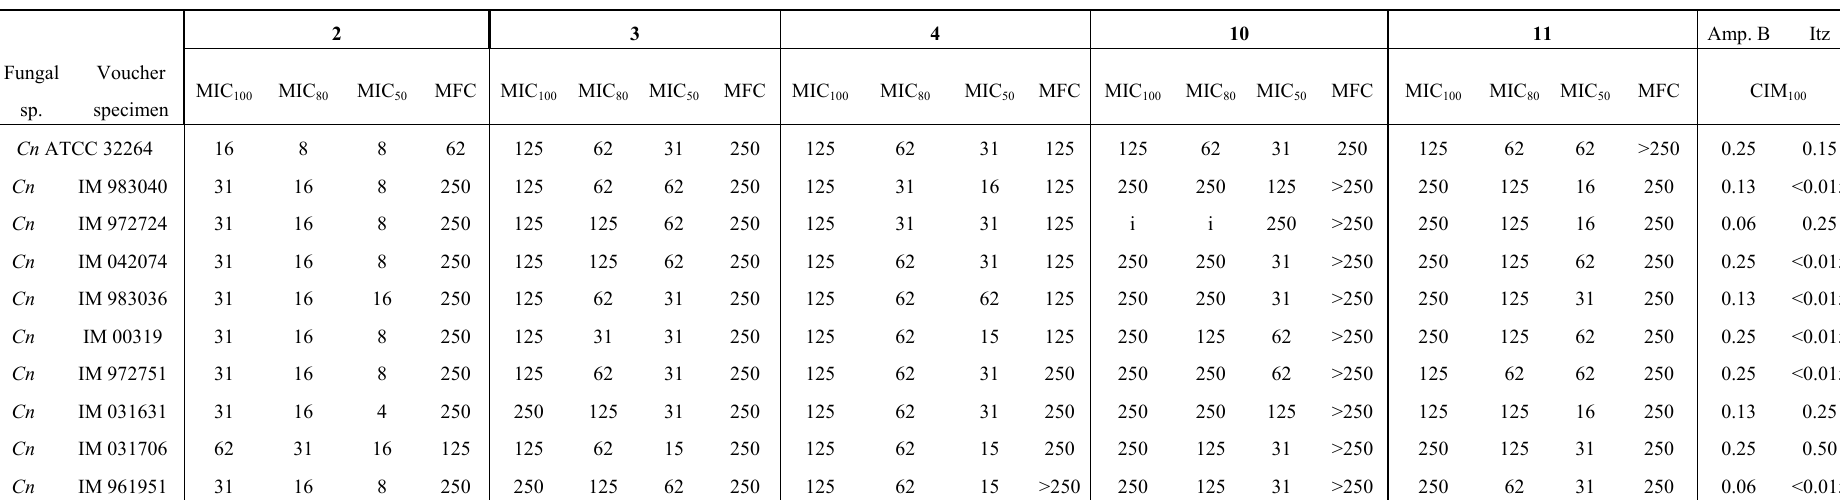
Table 3. Minimum Inhibitory Concentrations (MIC derivatives 2–4 , 10 and 11 against clinical isolates of Cryptococcus neoformans . For the sake of comparison, the MIC and MFC values of both compounds against an ATCC standardized strain of C. neoformans are